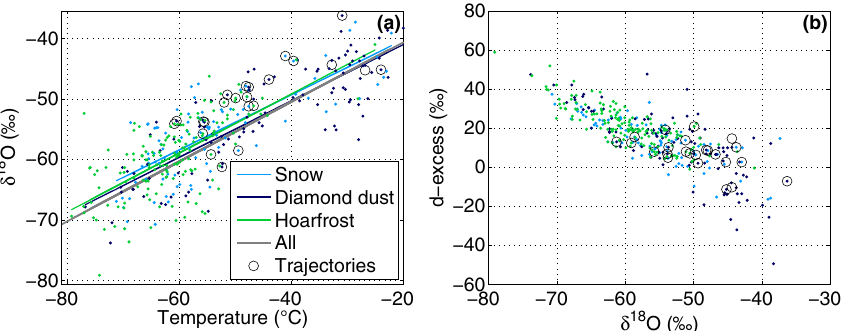
Figure 8. (a) δ 18 O of precipitation samples vs. 2m air temperature from an AWS for the different types of precipitation, snow, diamond dust, and hoarfrost. High-precipitation events, for which trajectories were calculated, are marked with circles. (b) δ 18 O of precipitation samples vs. deuterium